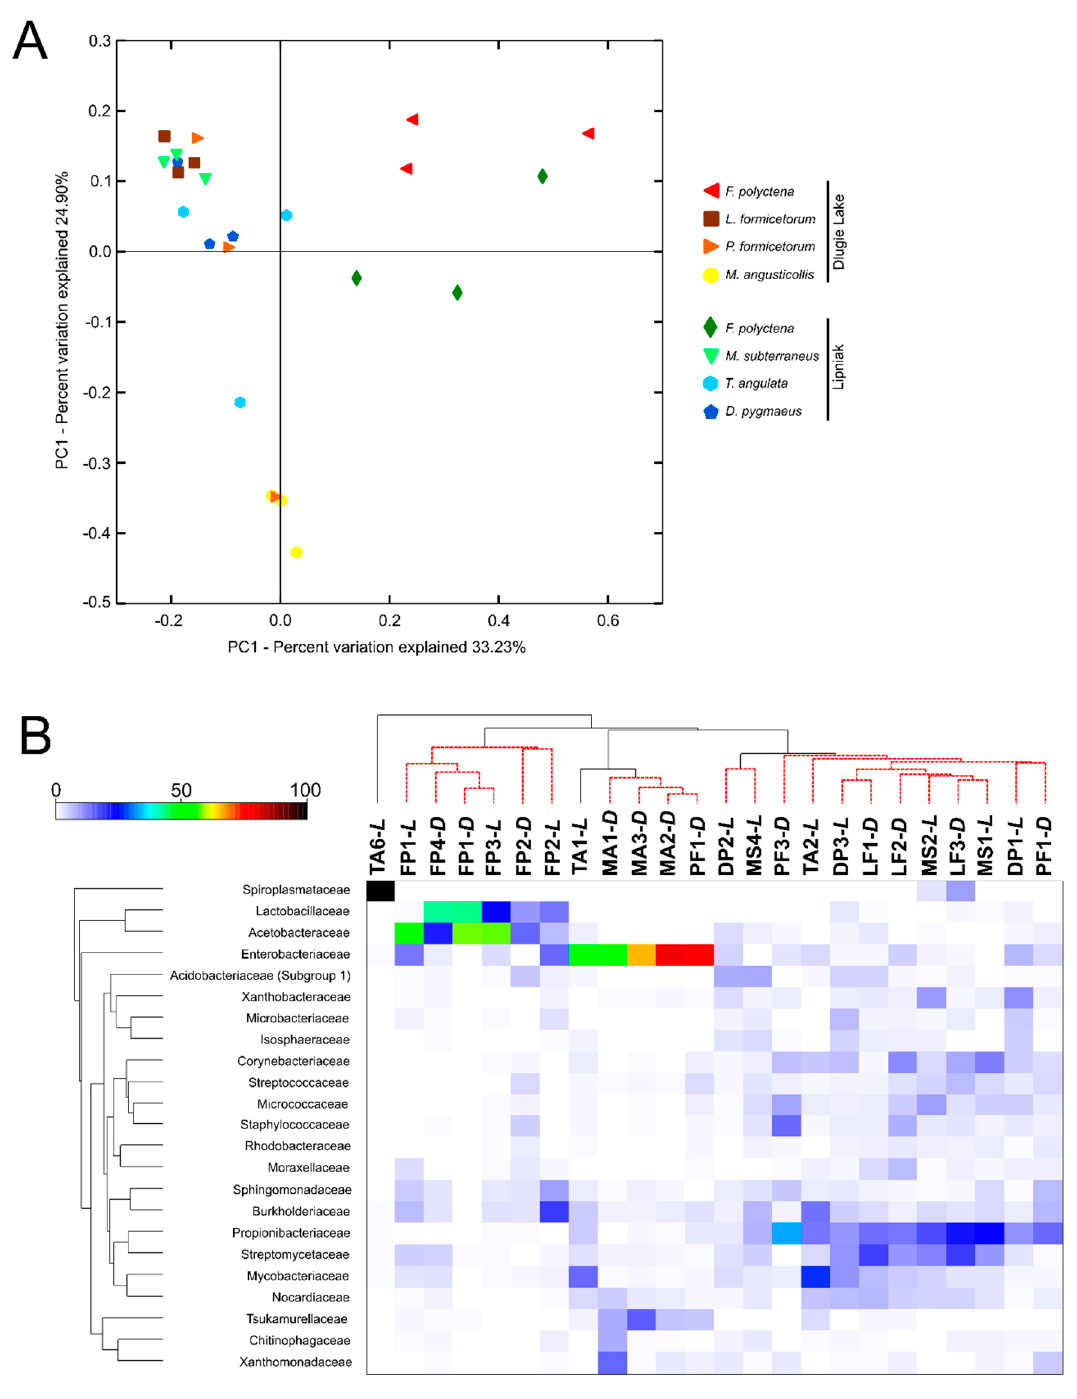
Figure 4. Principal Coordinate Analysis (PCoA) plot and the heatmap showing relationships among tested microbiome profiles after filtering Wolbachia and Rickettsia reads out. ( A ) PCoA of bacterial communities associated with tested specimens based on weighted UniFrac distances; ( B ) the heatmap showing bacterial families distributed across tested samples. Only those families who were primarily responsible for the observed differences among samples were considered. Both dendrograms were estimated with the Bray–Curtis dissimilarity index.